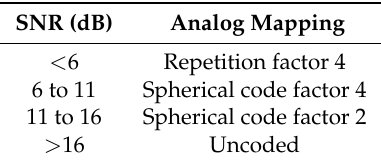
Table 3. Mappings for s 1 (see Table